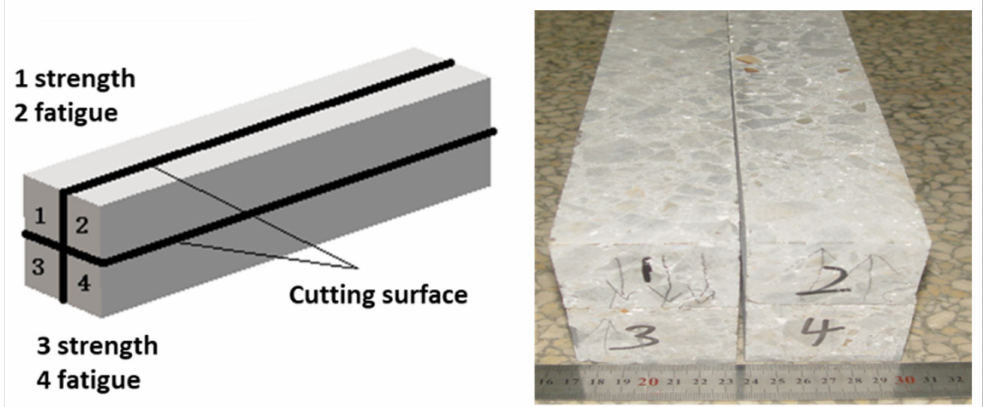
Figure 1. Testing beam specimens from a large beam specimen for the strength and fatigue